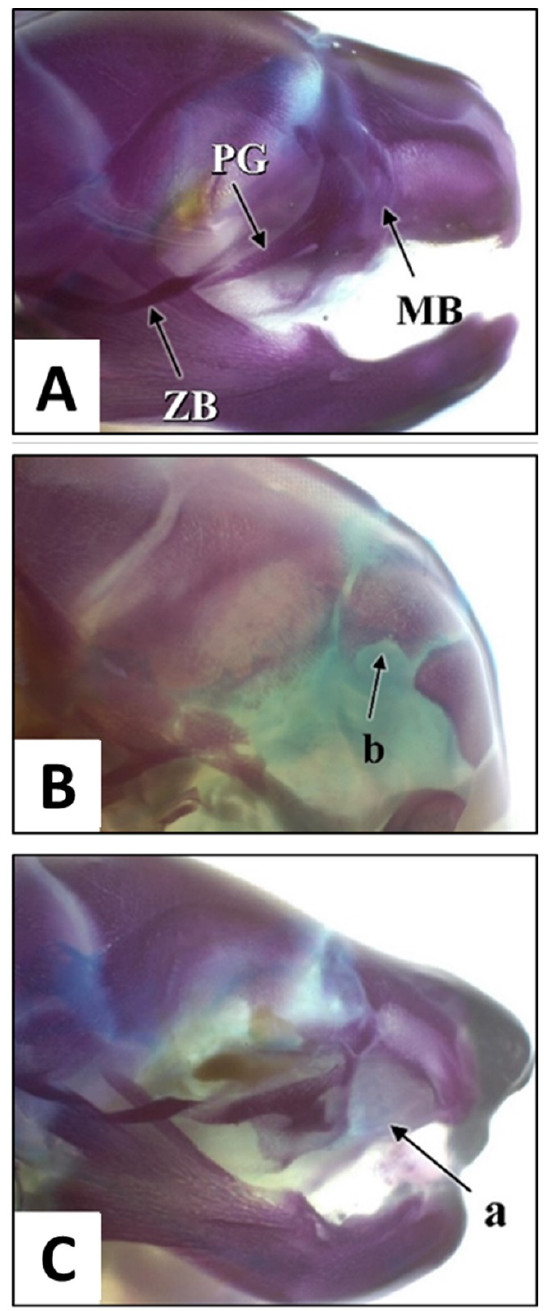
Figure 4. Photographs of foetal heads showing the zygomatic (ZB), processus jugalis of maxilla (PG) and maxillary bone (MB) of foetal rat. Normal ZB, PG and MB ( A ); incomplete ossification of interparietal (IP) bone indicated by ‘b’ ( B ); and maxillary bone defect ( C ), indicating presence of cleft palate (a) in a foetus from AHAE 1000 mg/kg group.